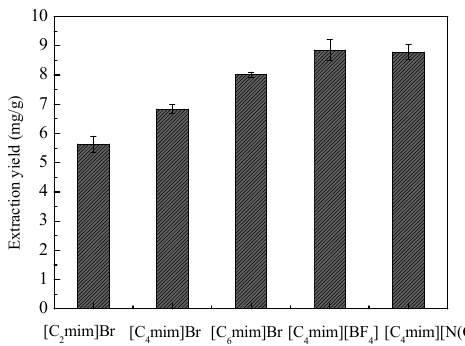
Figure 2. UAE of total flavonoids from A. venetum L. leaves using different ILs.